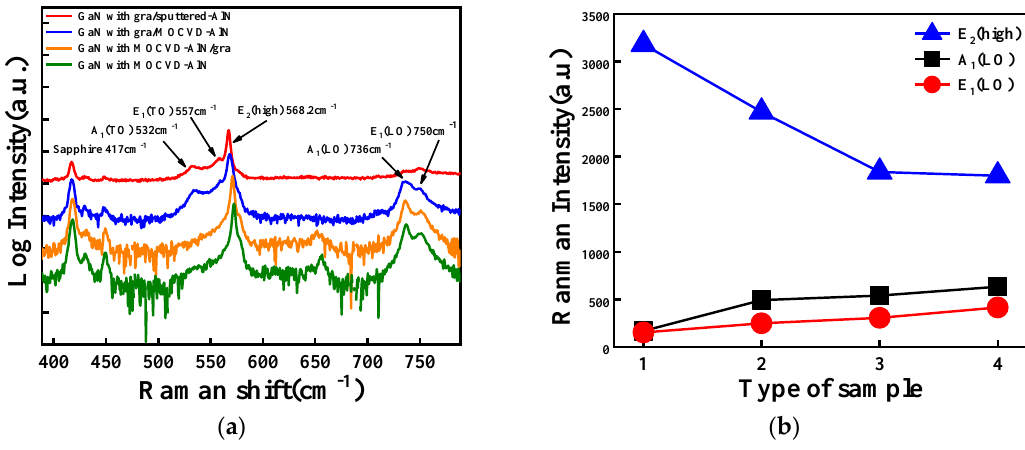
Figure 3. ( a ) Raman spectra of the GaN films grown on sapphire substrate with graphene / sputtered AlN bu ff er layer (sample1), graphene / MOCVD AlN bu ff er layer (sample 2), MOCVD AlN / graphene bu ff er layer (sample 3), and MOCVD AlN bu ff er layer (sample 4) in the low-wave region of 300–800 cm − 1 ; ( b ) the intensity of the A 1 (LO) phonon, E 1 (LO), and E 2 (high) of Raman spectra of the GaN films in the four di ff erent